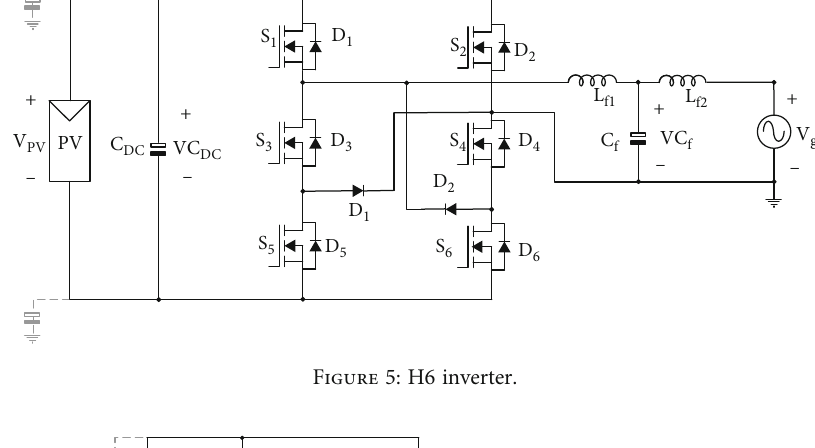
Figure 5: H6 inverter.